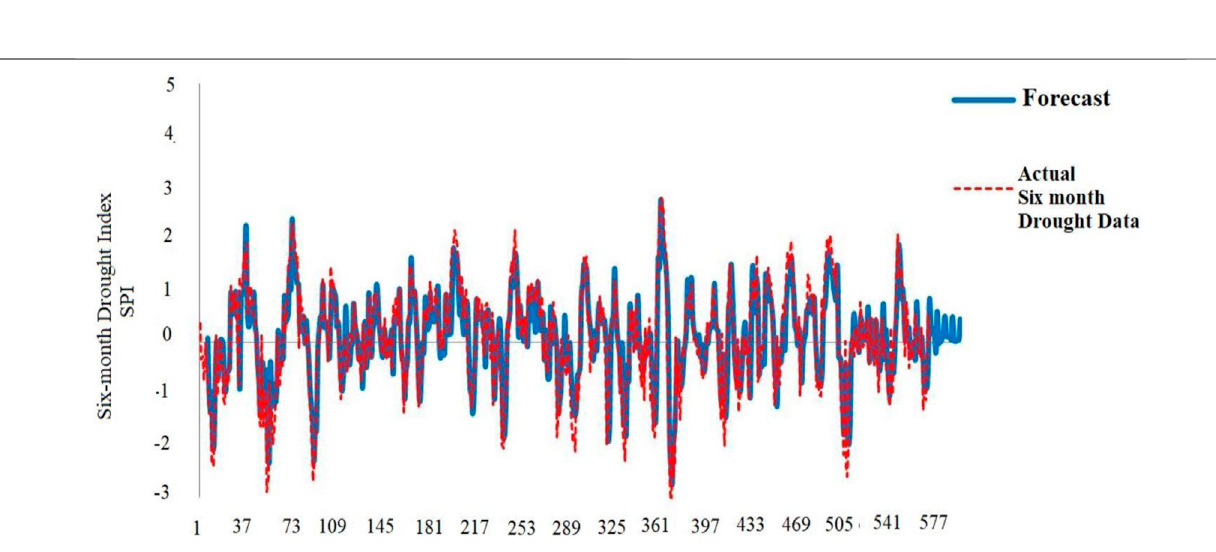
Frontiers in Earth Science |